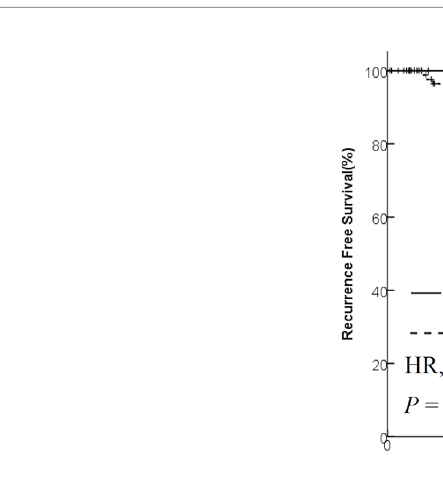
FIGURE 4 | Kaplan – Meier curves for recurrence-free